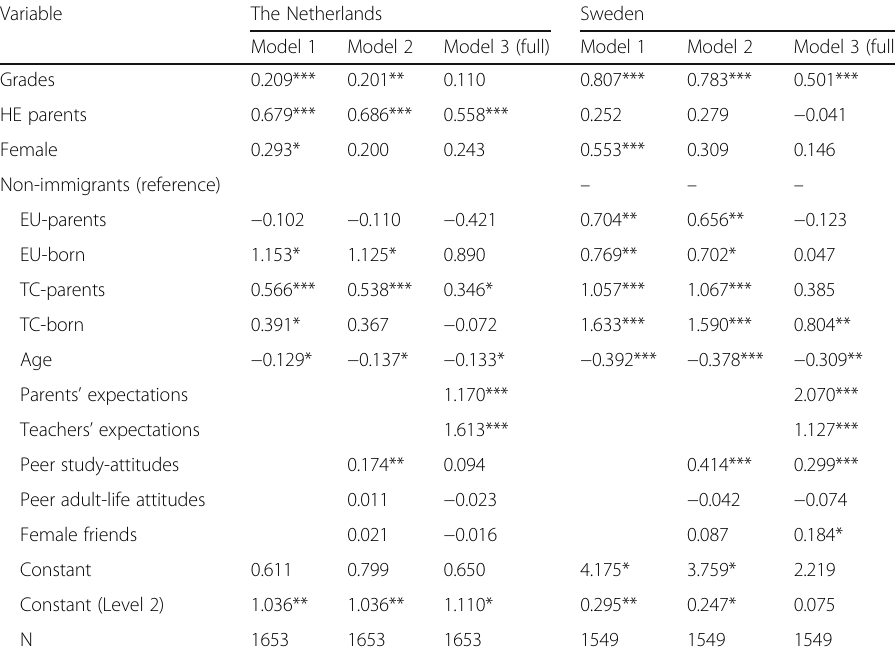
Table 3 Multi-level logit regressions. The effects of significant others on Dutch & Swedish